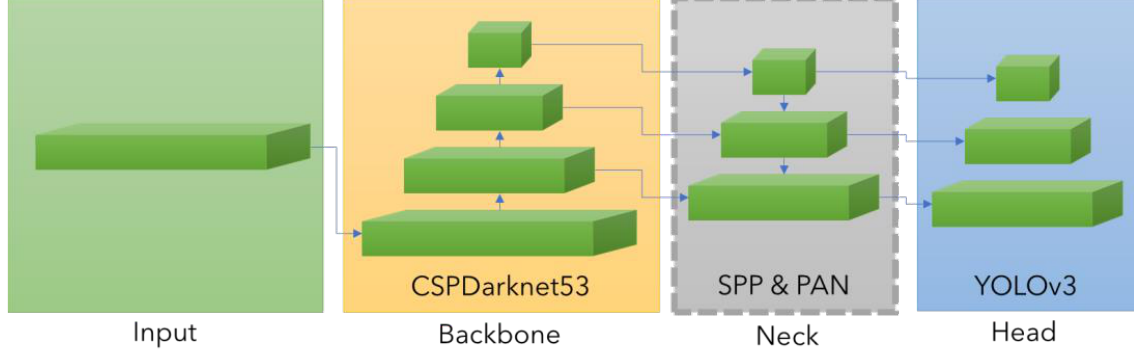
Figure 5. Simple architecture of YOLOv4 [44].